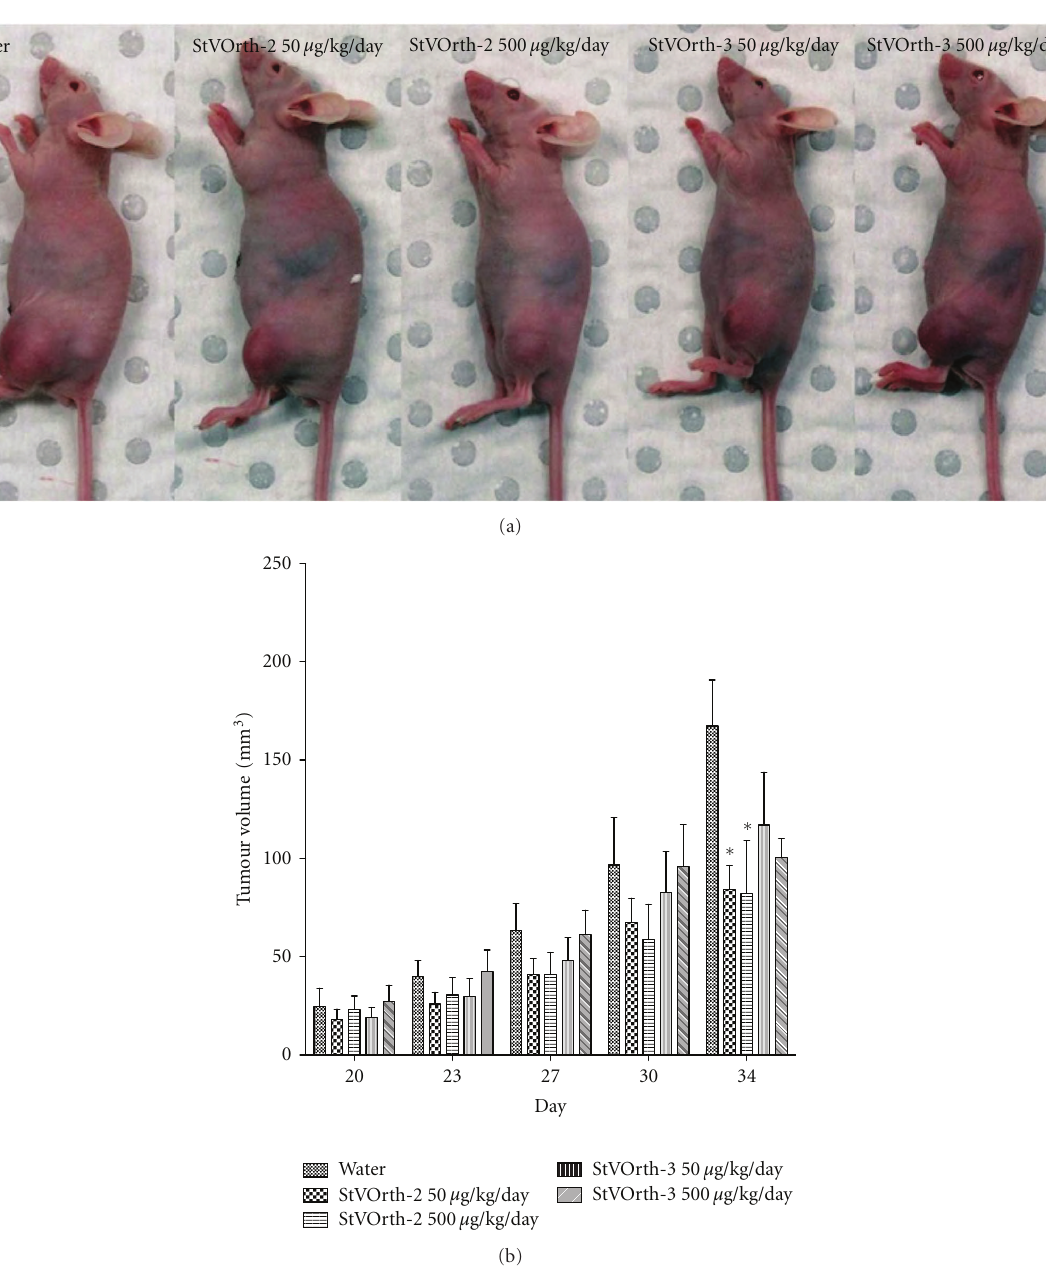
Figure 3: Systemically delivered StVOrth-2 inhibits growth of orthotopic osteosarcoma. (a) Photomicrographs of mice showing left tumour- bearing hindlimbs. (b) Tumour volumes recorded at days 20, 23, 27, 30, and 34 after SaOS-2 intratibial injection ( ± SEM). ∗ P < 0 . 01, two-way